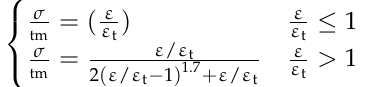
strain corresponding to the average tensile strength. According to the brick masonry’s uniaxial tensile strength ( f tm = 0.386 MPa) and tensile peak strain ( ε t = 0.000157), the tensile